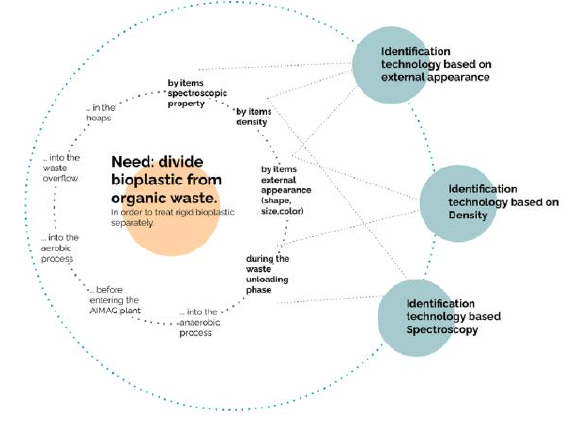
Fig. 7. Divergence Map AIMAG